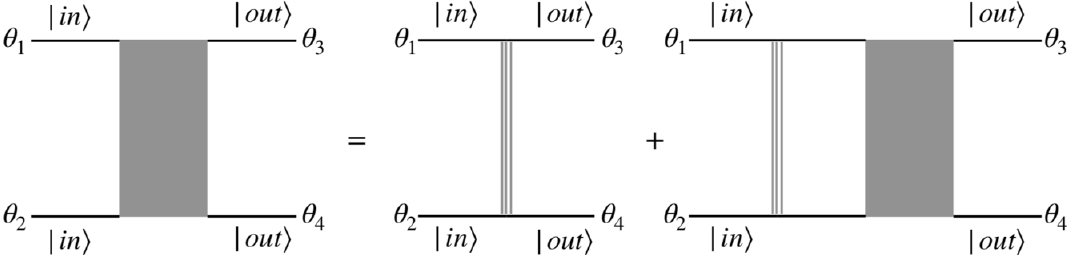
Figure 2 . A schematic representation of the Dyson-Schwinger diagram for computing the planar all-loop four-point correlator. The striped diagrams are tree-level contributions. The solid blob is the contribution from all